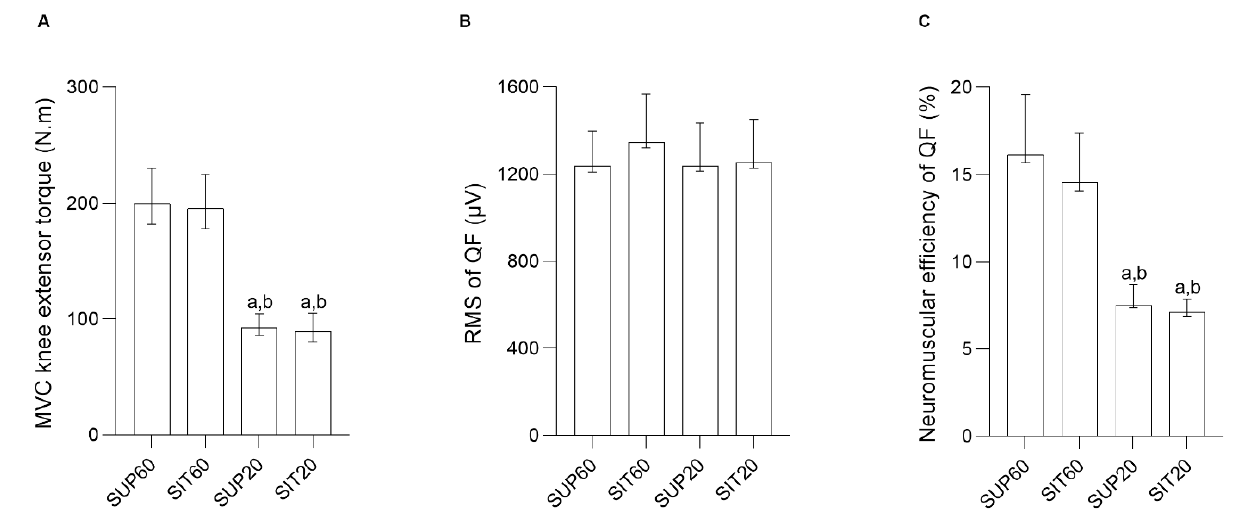
Figure 4. MVIC knee extensor torque, Root Mean Square and neuromuscular efficiency of the quadriceps femoris constituents according to hip and knee angles during contraction. ( A ) MVIC knee extensor torque (N.m) (left y -axis) and different conditions (right x -axis). ( B ) Root Mean Square of quadriceps femoris ( µ V) (left y -axis) and different conditions (right x -axis). ( C ) Neuromuscular efficiency of the quadriceps femoris (%) (left y -axis) and different conditions (right x -axis). Data are presented as geometric means and confidence intervals (CI 95%). Legend: MVIC: Maximal Voluntary Isometric Contraction; RMS: Root Mean Square; QF: Quadriceps femoris; SUP60: supine with 60 ◦ of knee flexion; SIT60: seated with 60 ◦ of knee flexion; SUP20: supine with 20 ◦ of knee flexion; SIT20: seated with 20 ◦ of knee flexion. Significant differences: a different from SUP60 at ( p ≤ 0.05). b different from SIT60 at ( p ≤ 0.05).